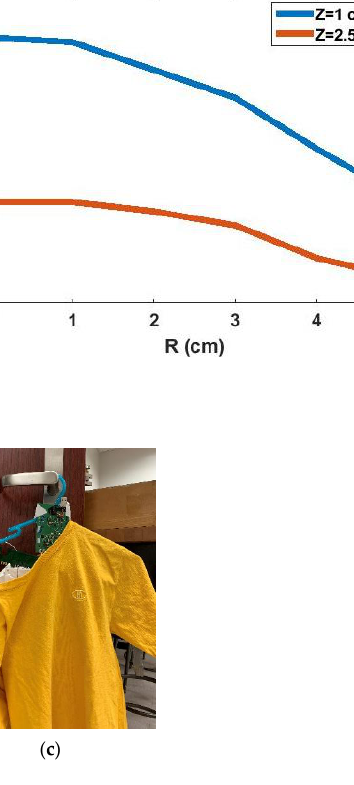
Table 2. Properties of the wireless-charging hanger ’s TX coil.